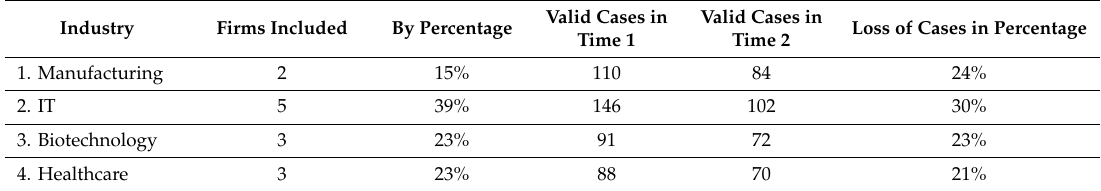
Table 1. Description of investigated and industries and firms; valid cases in each time stage.